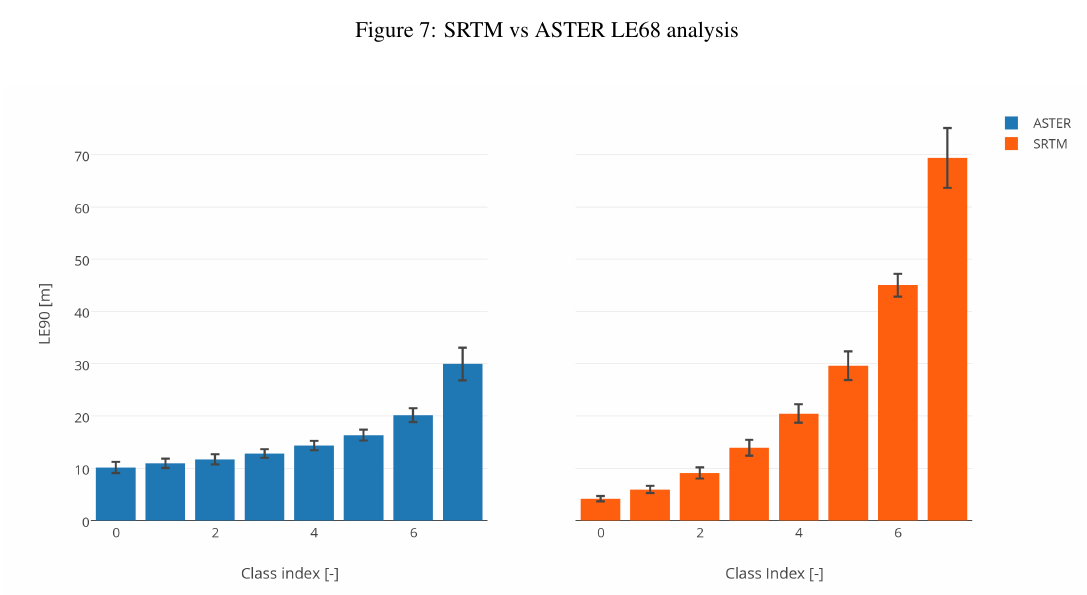
Figure 7: SRTM vs ASTER LE68 analysis